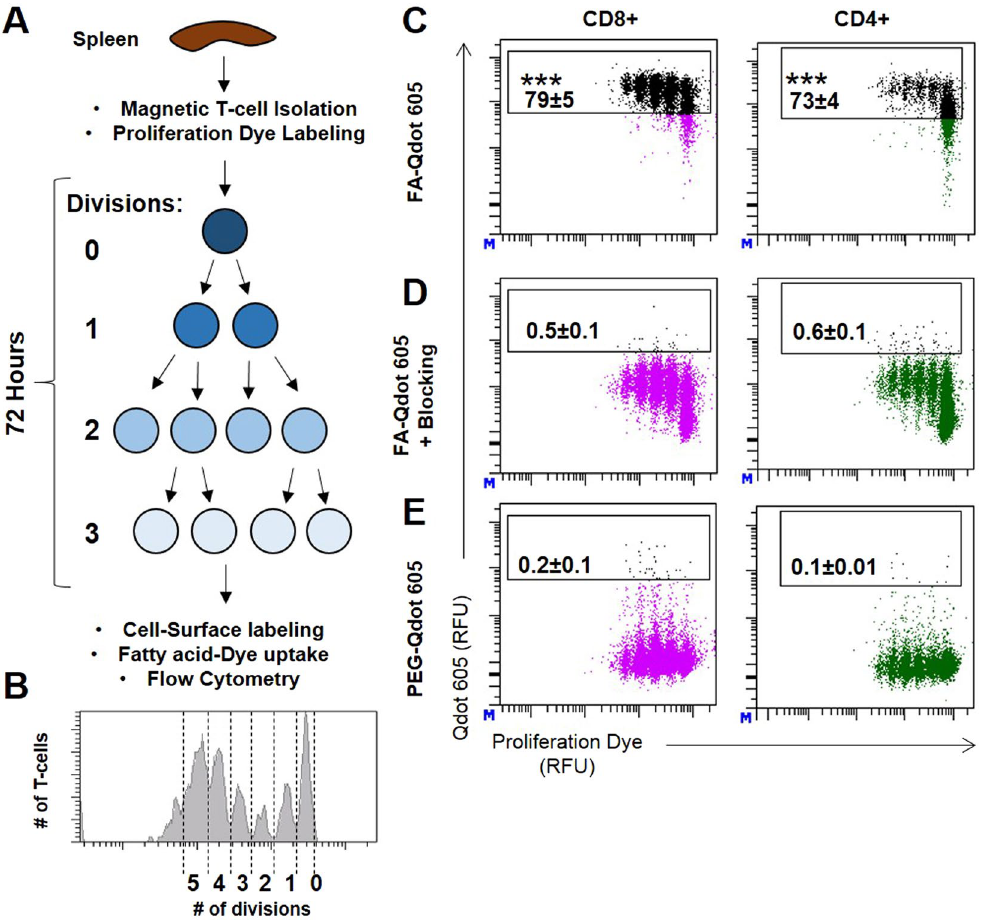
Figure 2. FA-Qdot 605 can accurately determine uptake by proliferating murine lymphocytes in culture. In ( A ), A schematic depicting isolation and labeling of T-cells with viability dye, followed by the steps before flow cytometric analysis. Importantly, after dye labeling, a cell will lose ½ of the dye each division, resulting in distinct peaks indicating cycles of proliferation. This parameter is normally shown as a histogram ( B ); however, with the inclusion of our FA-Qdot, we can compare the number of cellular divisions (X-axis) to amount of Fatty Acid uptake (y-axis) ( C – E ). In ( C – E ), Cell Trace Violet (CTV)-labeled T-cells were cultured under stimulating conditions of anti-CD3/anti-CD28 treatment for 72 hours and assayed for FA uptake utilizing flow cytometric analysis. In ( C ), stimulated T-cells were stained for T-cell markers and then incubated with 10nM of FA- Qdot 605 conjugate for 3 minutes before running flow analysis. In ( D ), to confirm specific uptake, stimulated T-cells were pre-incubated with 10X unlabeled palmitic acid for 10 minutes before staining with FA-Qdot 605 conjugate as in C. Amine-bound Qdot 605 was used in ( E ) to stain T-cells to test for non-specific uptake. Results are compiled from four separate experimental wells per group and is representative of 2 experiments. Statistics calculated as a percentage of the positive population ± SEM. One-way ANOVA, followed by Tukey’s post-hoc analysis, was used to calculate significance. p < 0.05 * ; p < 0.01 ** ; p < 0.001 *** . Relative Fluorescence Units =